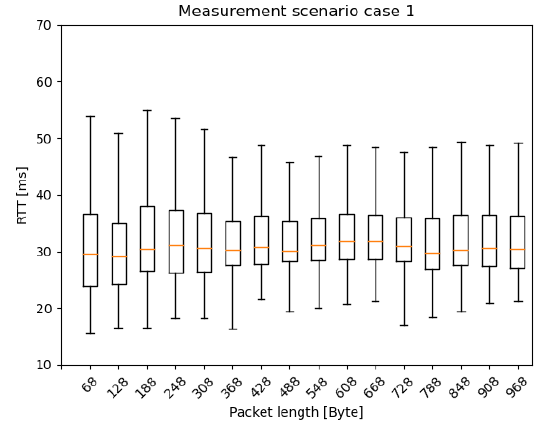
Figure 13. RTT results with different packet lengths—scenario 1: from 2 ms IAT and 60 Byte PL to 62 ms IAT and 960 Byte PL, increment the PL by 60 Byte PL for every iteration and the IAT by 20 ms for every fourth